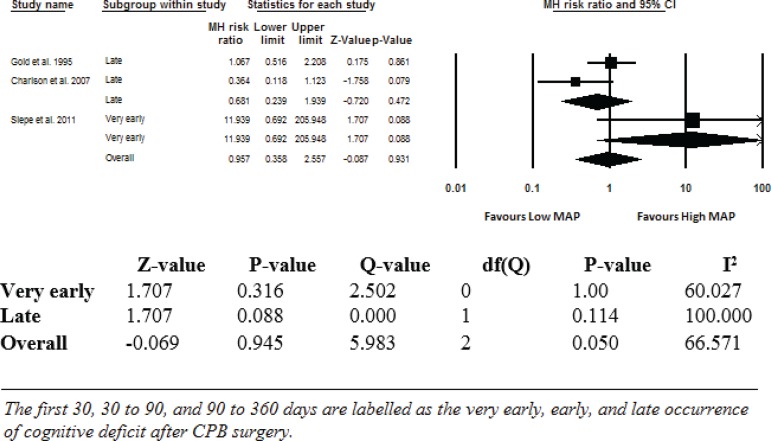
Comparison of patients in low MAP and high MAP.